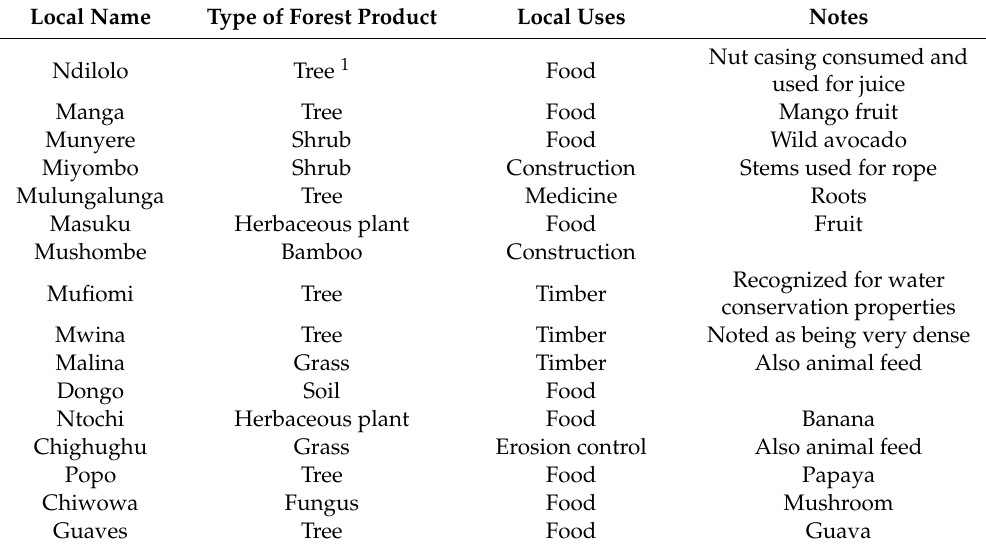
Table 3. Inventory of forest